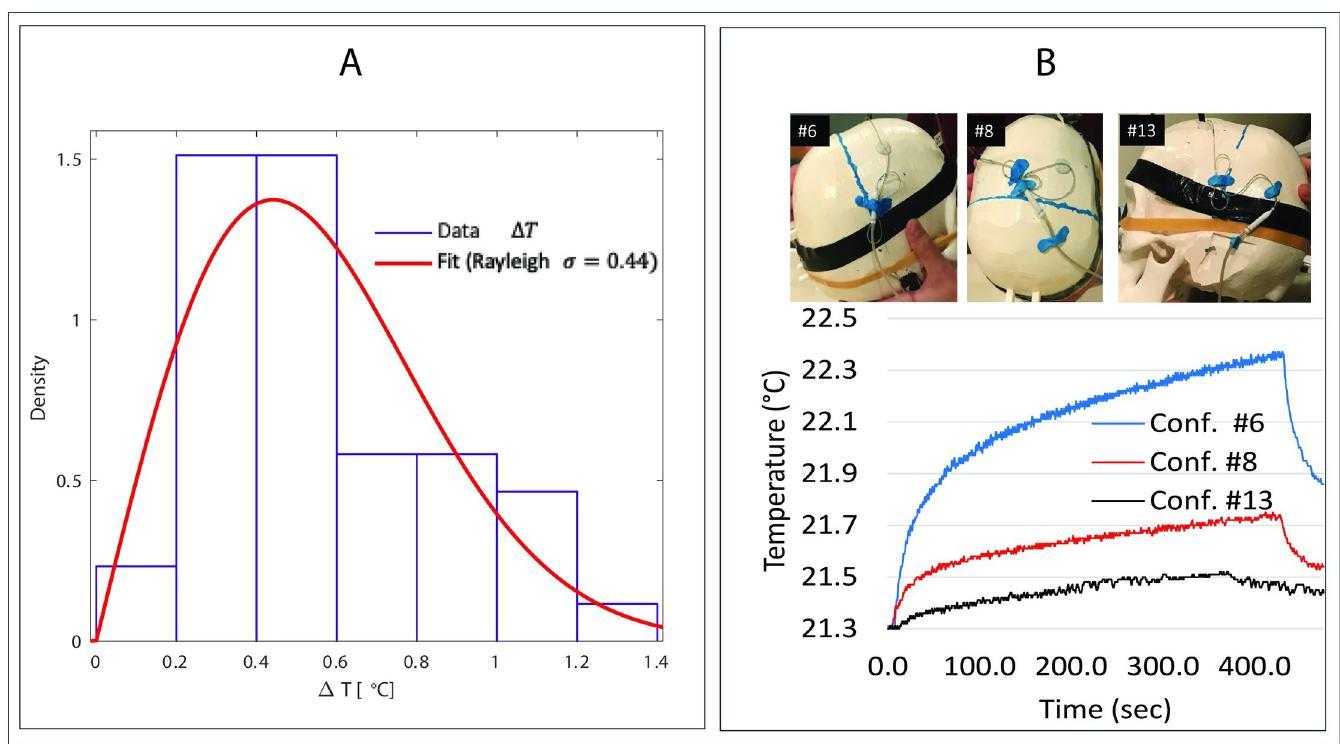
Fig 6. RF heating results. (A) Distribution of pooled data (n = 43) fitted to a Rayleigh probability distribution MATLAB. (B) Temporal profile of temperature rise for three configurations (Conf #6, #8 and #13 as shown in the attached pictures) for full DBS system, representing maximum, intermediate and the minimum heating